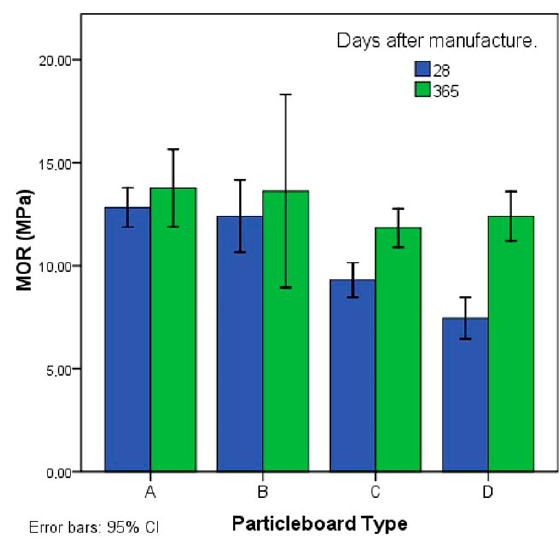
Figure 4. Modulus of rupture (MOR) after 28 and 365 days. CI, confidence interval.